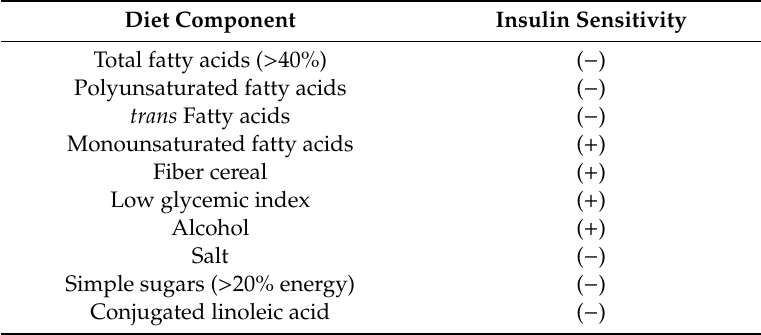
Table 1. Influence of diet on insulin